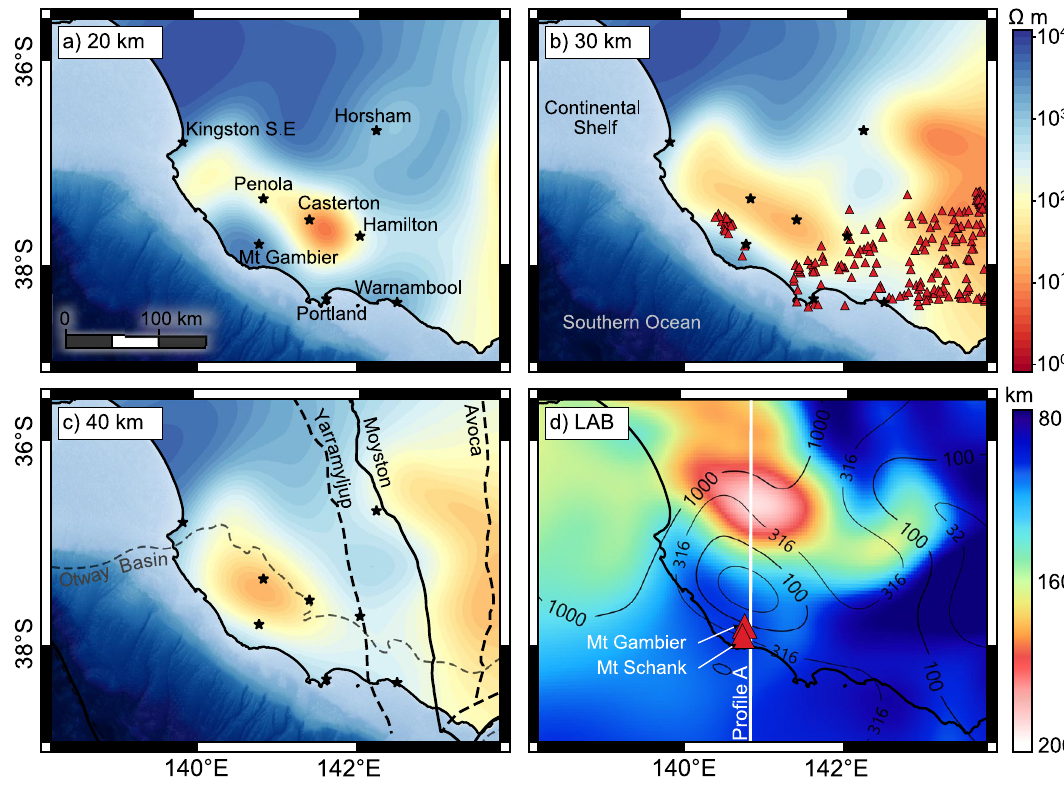
Figure 2. ( a ) resistivity at 20 km depth with overlying population centres. ( b ) resistivity at 30 km depth with volcanic centres of the Newer Volcanics Province 3 (red triangles). ( c ) resistivity at 40 km depth with major crustal features and outline of the Otway basin. ( d ) depth in km to the seismically defined lithosphere- asthenosphere boundary (LAB) 14 overlain with resistivity contours at 40 km depth. Profile A illustrates the cross-section from Fig. 3 and is aligned N-S approximately parallel to local plate motion (~ 356–003°N, relative to a fixed hotspot reference frame 33–35 ). Visualisation created using the free and open source QGIS v3.22.8 (https:// qgis.